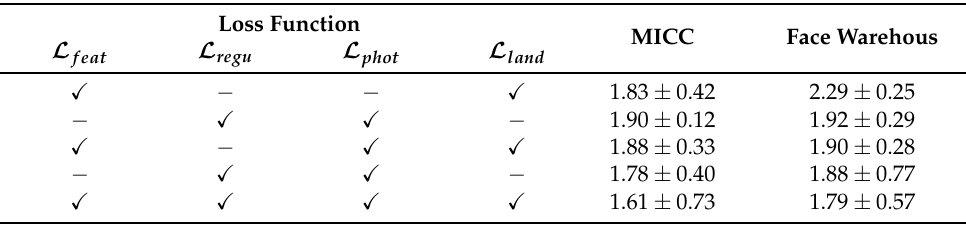
Table 1. Average reconstruction errors (mm) on MICC datasets [92] and FaceWarehouse datasets [93] for ResNet trained with different loss combinations.“ (cid:88) ” denotes employed, while “ − ” denotes unemployed. Our total hybrid-level loss yields considerably higher accuracy than other baselines on the two datasets.